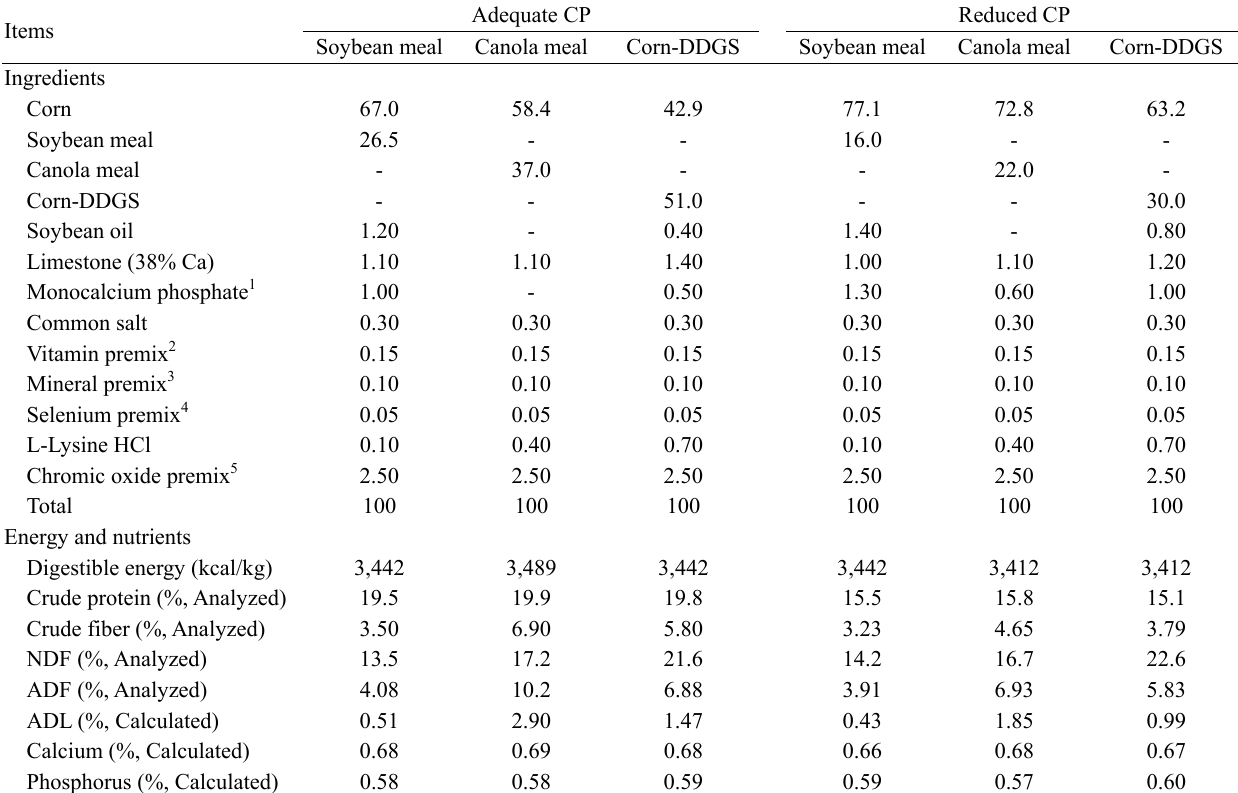
Table 1. Ingredient and chemical composition of diets to determine the effect of protein feedstuff and protein level on apparent or standardized ileal digestibility of amino acids in growing